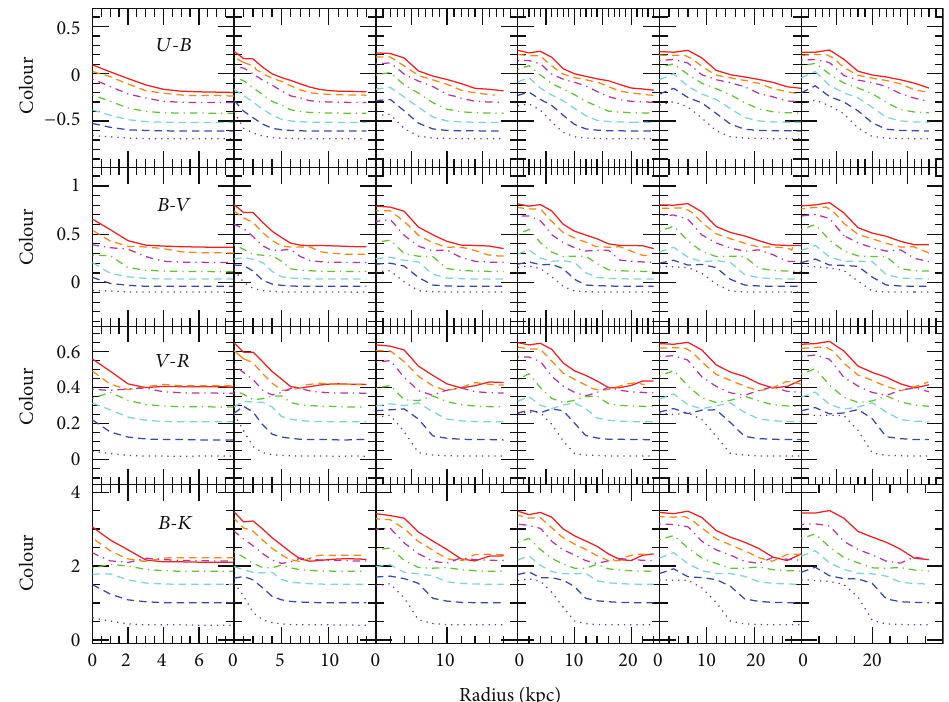
Figure 15: Evolution of colors radial profiles for 𝑈 - 𝐵 , 𝐵 - 𝑉 , 𝑉 - 𝑅 , and 𝑅 - 𝐼 . As in previous figures each color represents a redshift while each column is a different theoretical galaxy of Table 1, from the galaxy, with 𝑉 max = 78 kms −1 , to the most massive at the right for 𝑉 max = 290 kms −1 .